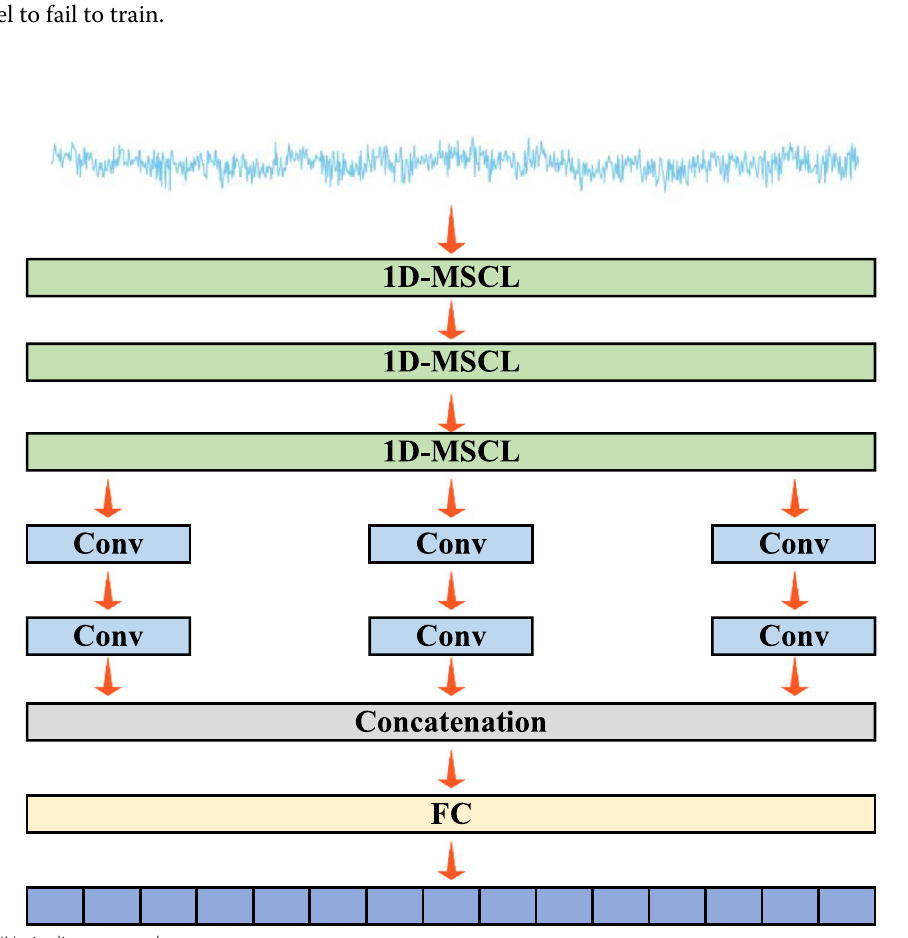
Fig. 2 The MSCNN pipeline